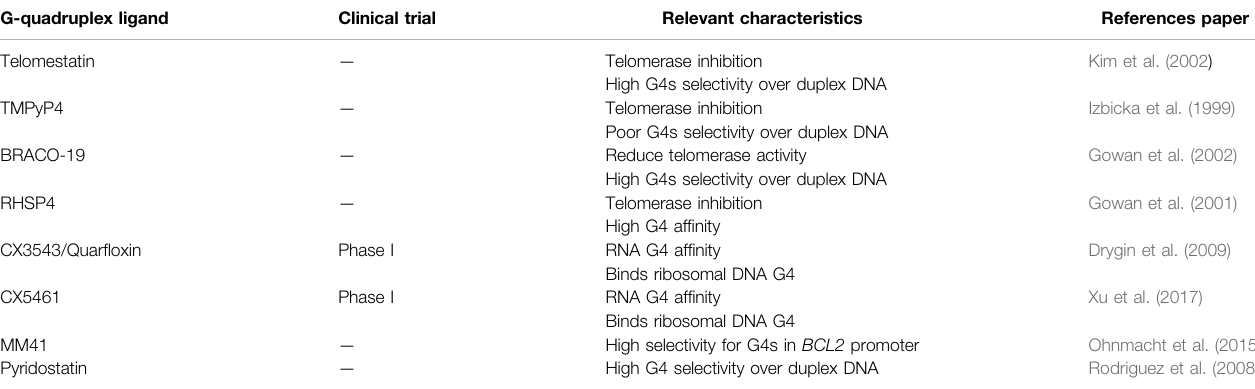
TABLE 1 | G-quadruplexes ligands and their main